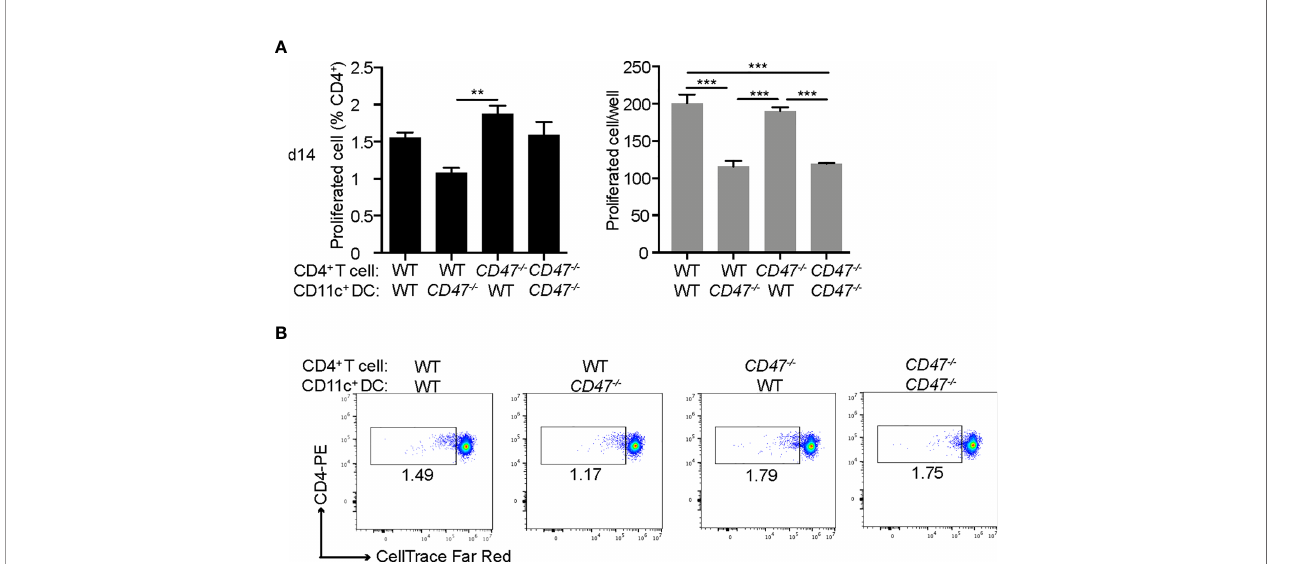
FIGURE 7 | DCs from CD47 de fi cient mice failed to stimulate T cells in antigen speci fi c response. WT and CD47 -/- mice (n=3-4) were immunized and SP and LN cells were collected 14 days post immunization. CD4 + T cells and DCs (CD11c + ) puri fi ed from pooled LN cells and SP cells, respectively, were incubated at a ratio of T cells: DCs =2:1 (2 × 10 5 : 1 × 10 5 /well) in the presence of 10 m g/ml IRBP-p in a 96 well U-bottom plate for 3 days. (A) Proliferated cells with reduced expression of CellTrace ™ Far Red in live CD3 + CD4 + cells were analyzed by fl owcytometry. (B) Representative fl ow cytometry plots. The samples were run triplicates. Data were analyzed by one-way ANOVA followed by Tukey ’ s multiple comparison. Data are expressed as mean ± SEM. **P<0.01;